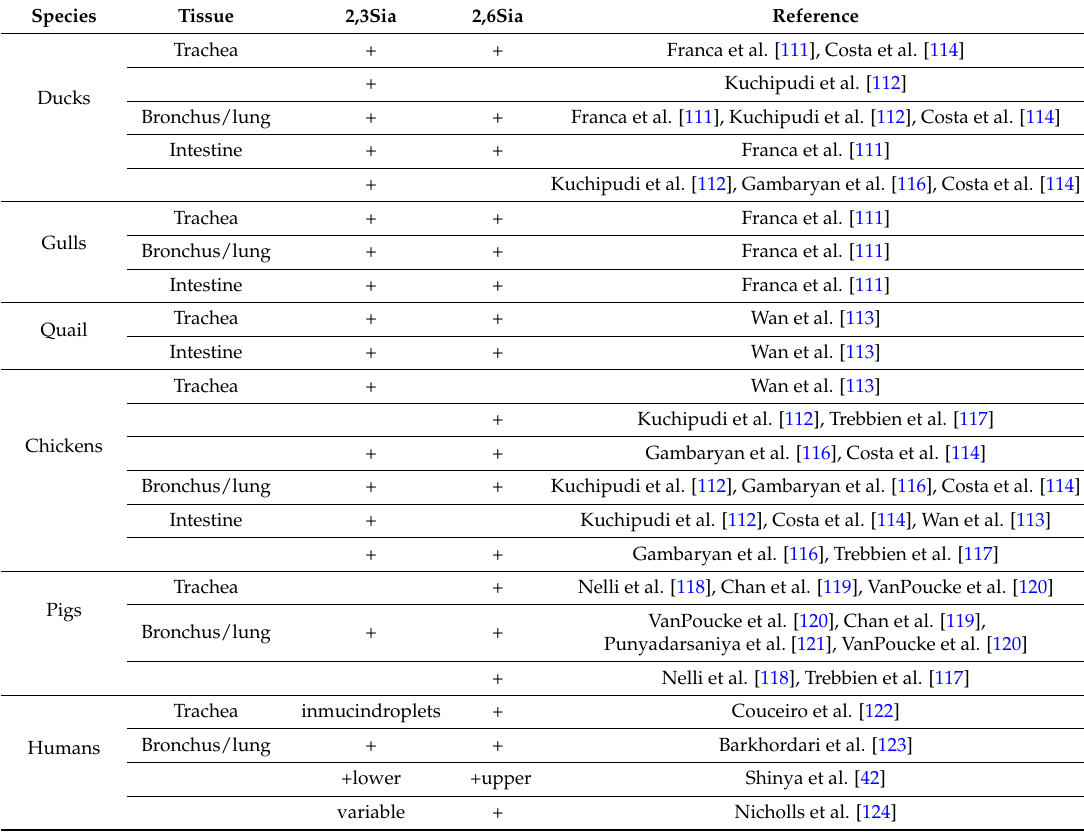
Table 1. Lectin histochemical staining of avian, swine and human